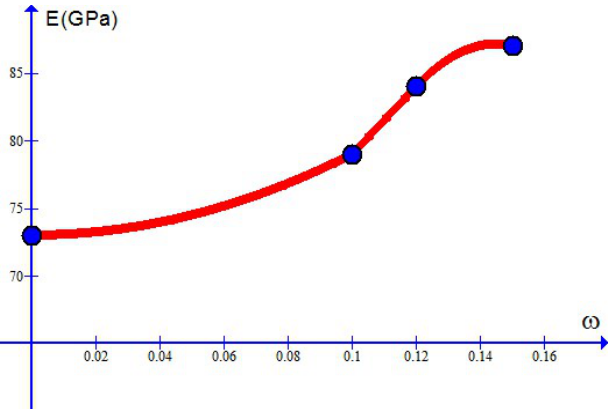
Figure 11. Young’s modulus E changing with the weight percentage ω (dots for simulation results).